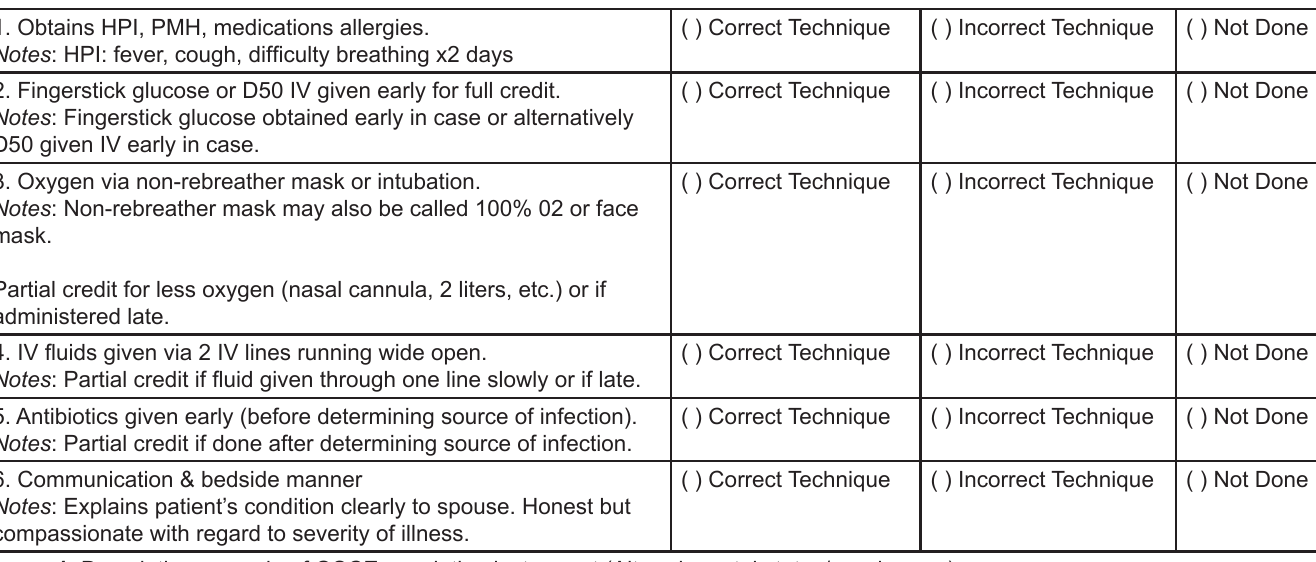
Figure 1. Descriptive example of OSCE evaulation instrument (Altered mental status/sepsis case) HPI , history of the previous illness; PMH , past medical history; IV , intravenous; OSCE, objective structured clinical